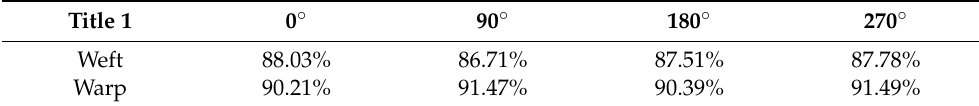
Table 1. The TRCR results of four regions.